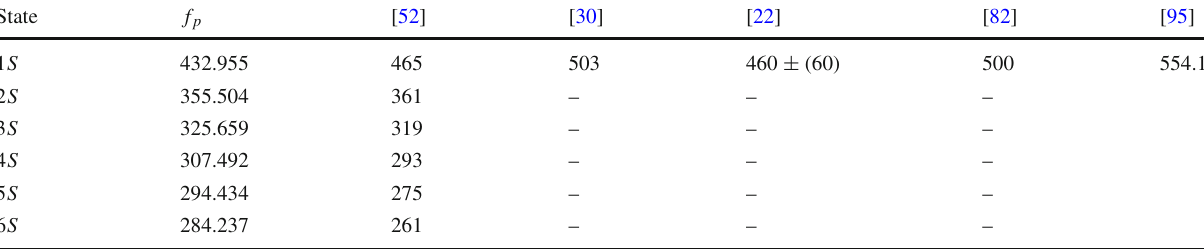
Table 12 Pseudoscalar decay constant of B c meson (in